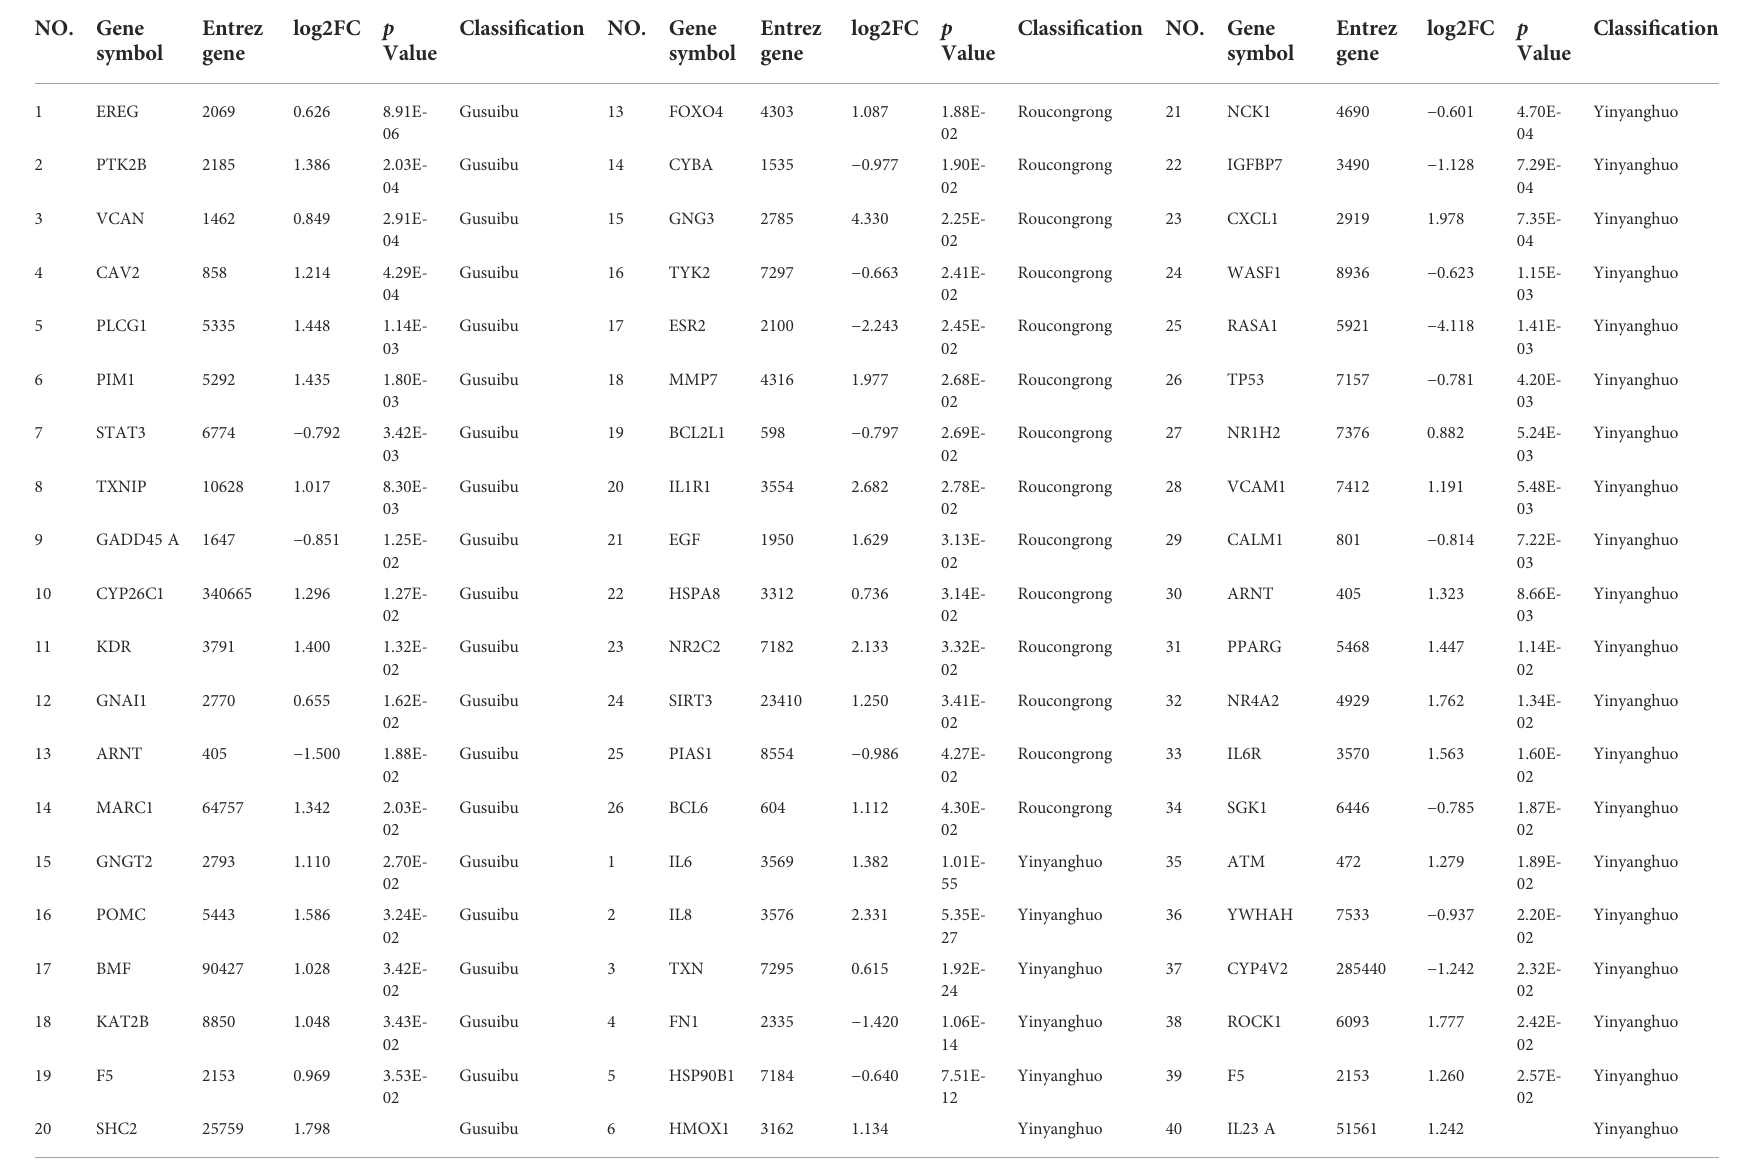
TABLE 3 92 DEGs of WSYR. Including 22 gusuibu DEGs, 26 RoucongrongDEGs and 54 yinyanghuo